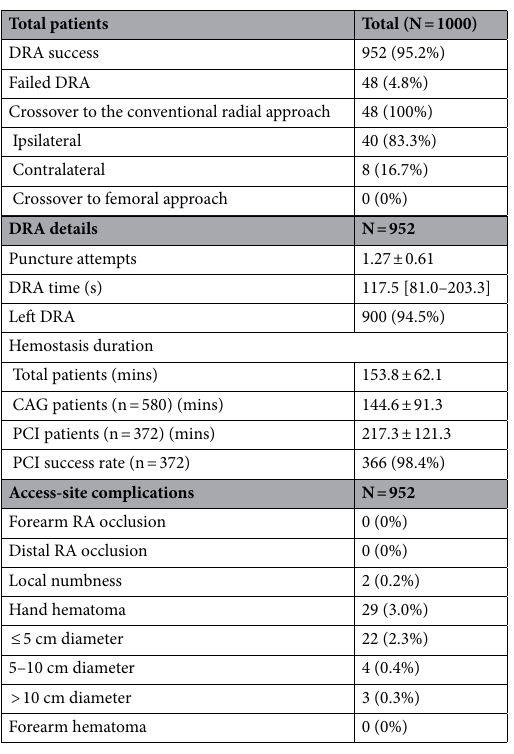
Table 1. Distal radial access characteristics and complications. Values are presented as mean ± standard deviation, numbers (%), or median [interquartile range]. DRA Distal radial access, CAG Coronary artery angiography, PCI Percutaneous coronary intervention, RA Radial artery.